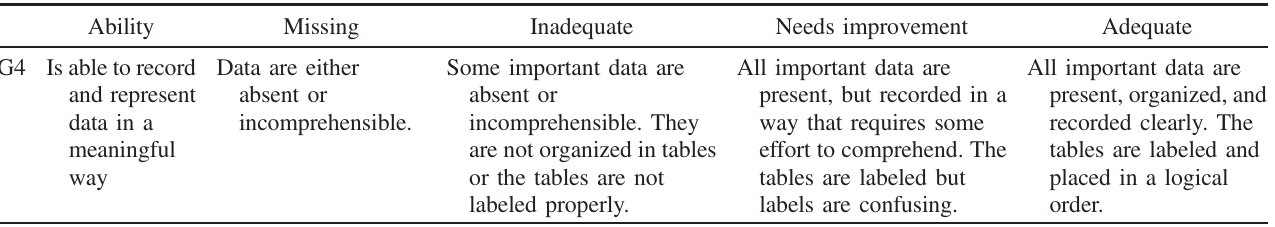
TABLE I. An example of a line in a rubric. This example is taken from the rubric to assess the “ ability to collect and analyze experimental data.